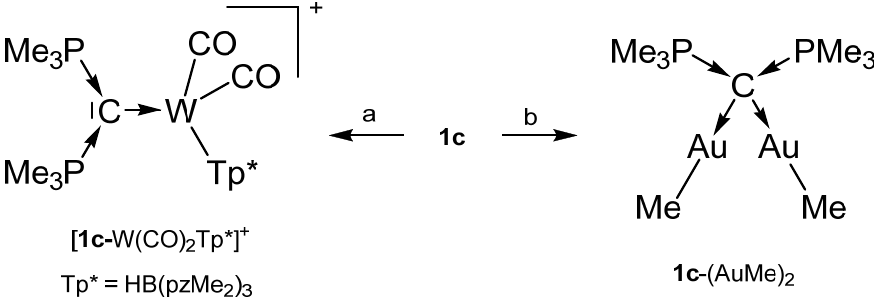
Scheme 2. Transition metal complex with the carbone 1c as two and four electron donor ligand.